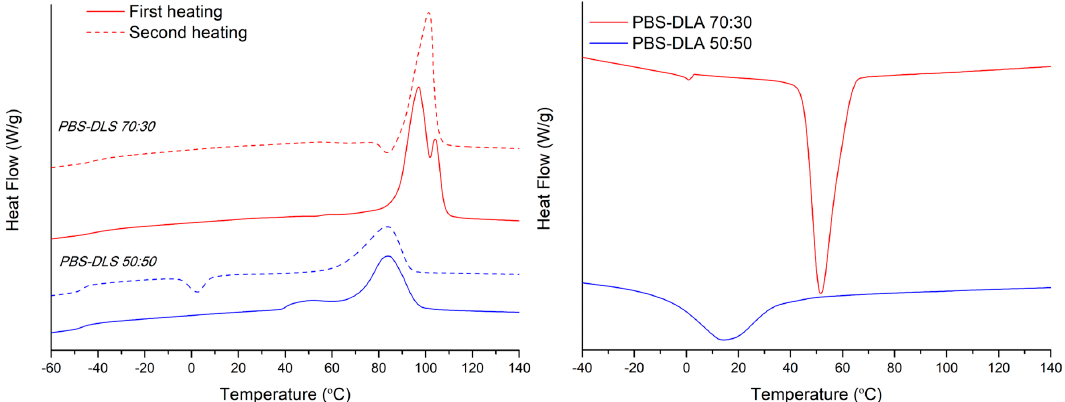
Figure 9. DSC thermograms. Left : first (solid line) and second heating (dashed line) scans of polymer powders (after synthesis) of PBS-DLS 50:50 (blue) and PBS-DLS 70:30 (red) copolymers. Right : cooling scan of polymer powders (after synthesis) PBS-DLS 50:50 (blue) and PBS-DLS 70:30 (red) copolymers.